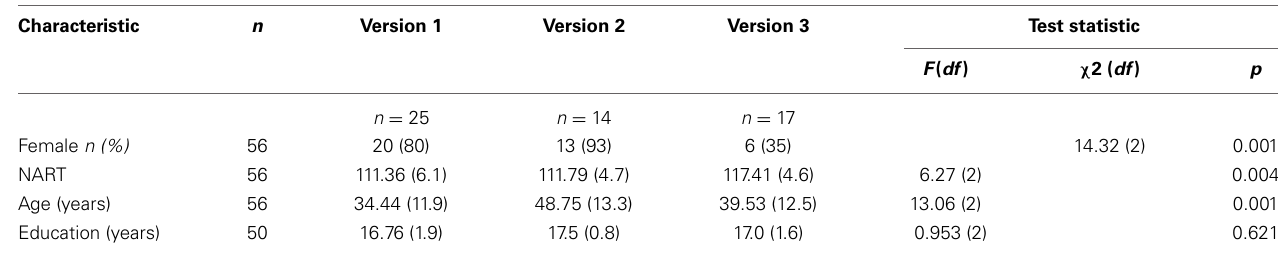
Table 1 | Demographic and education characteristics of study